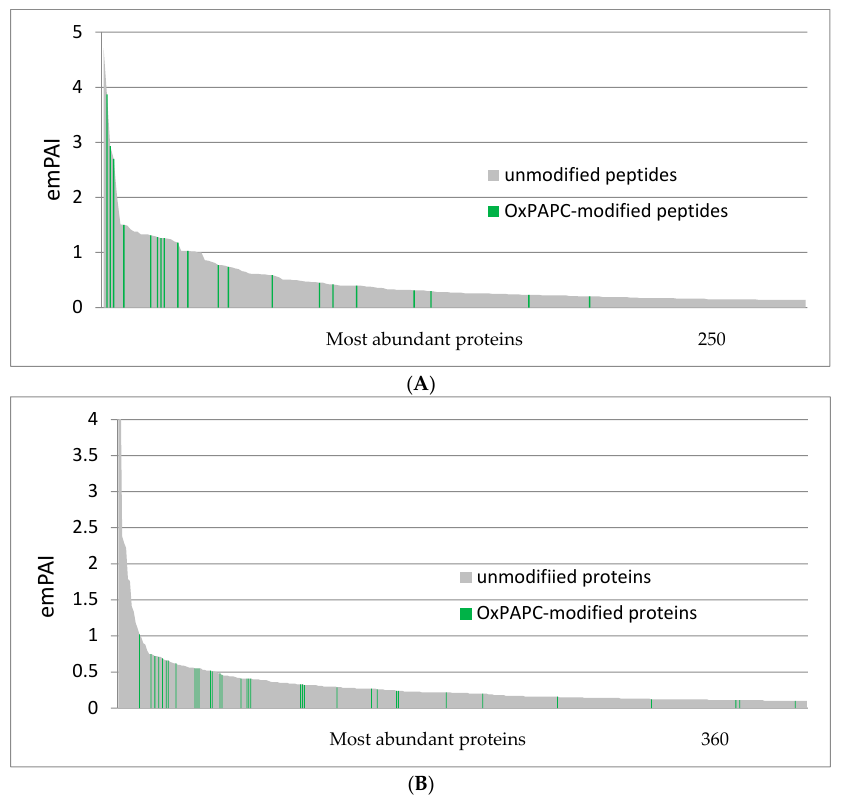
Figure 5. Protein abundance, based on exponentially modified protein abundance index (emPAI) score. Most abundant proteins, representing ~85% of total proteins, were plotted. The property of proteins to be modified by OxPAPC is not a simple function of their abundance. ( A ) PBS-soluble proteins; and ( B ) PBS-insoluble/RIPA-soluble proteins.